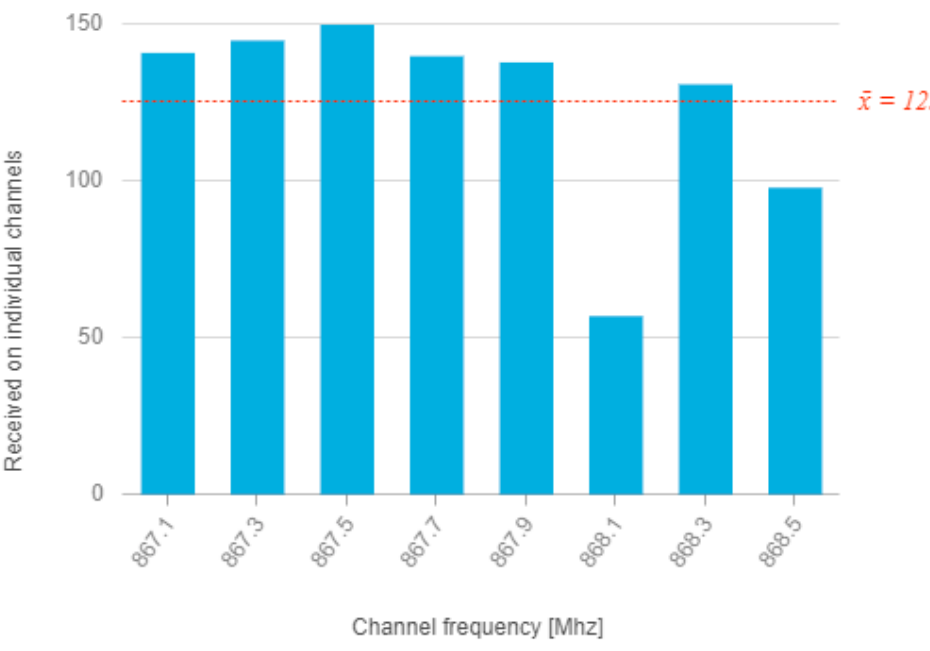
Figure 1. Number of received messages within individual LoRaWAN channels.